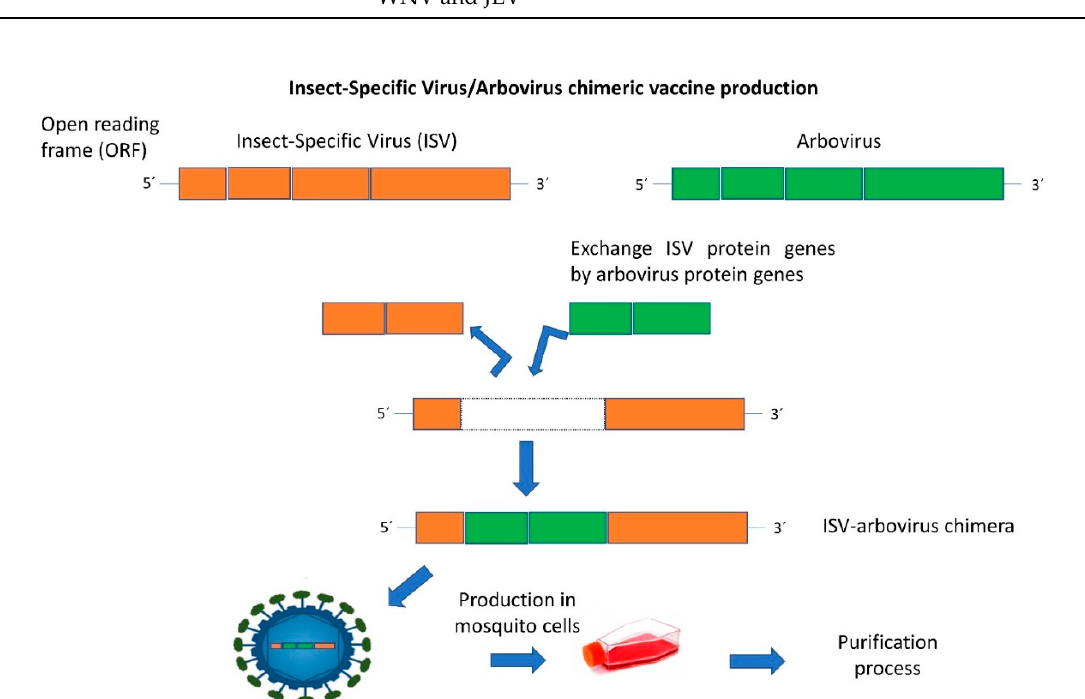
Figure 1. Schematic description of the development and production of insect-specific virus-based chimeric vaccines against arboviruses.